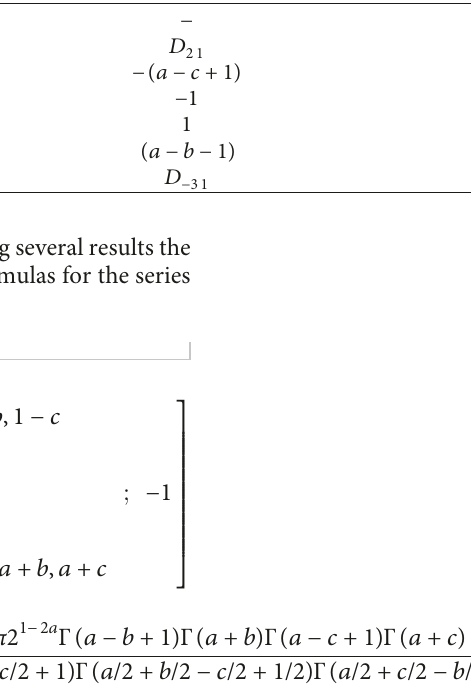
Table 4: Table for the coefficients D